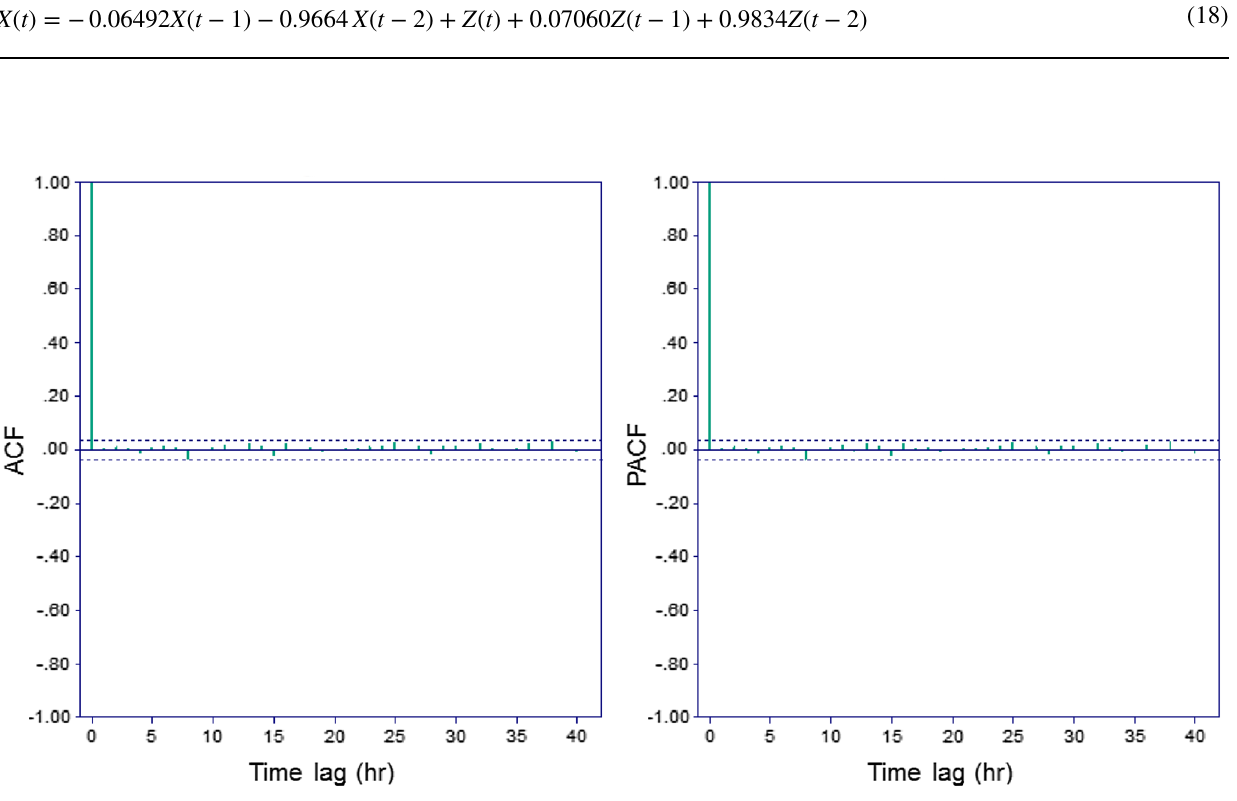
Fig. 3 Correlograms of the noisy pressure